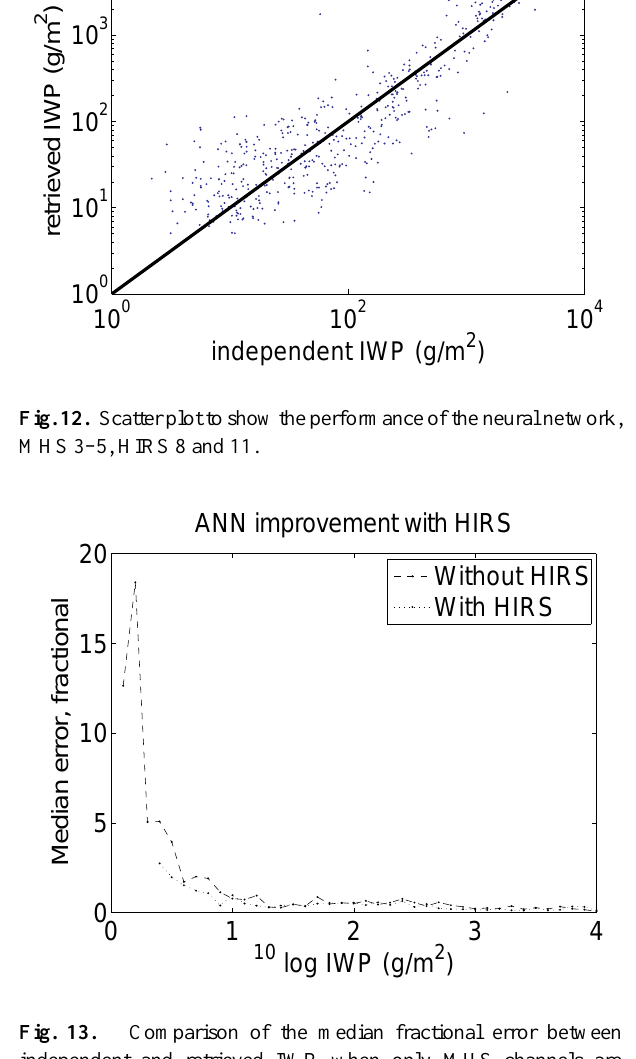
Fig. 11. ANN sensitivity to errors in the input brightness tempera- tures. Here, only the MHS channels are used as input to the ANN. See the text for an explanation and a discussion. collocations so that at least five CPR pixels are less than 10 km from the nearest HIRS pixel centerpoint.